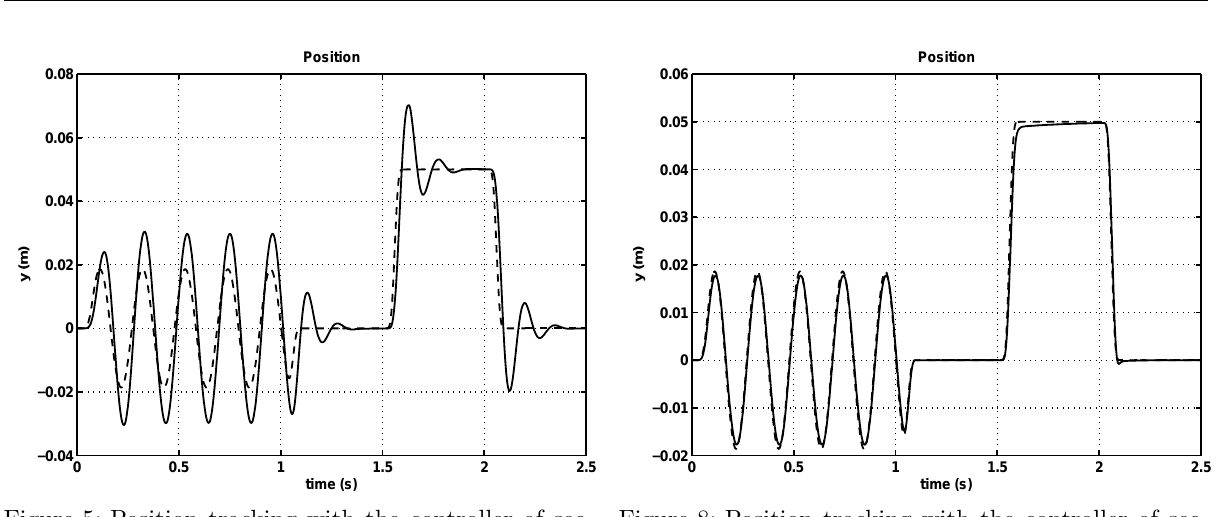
Figure 8: Position tracking with the controller of sec- tion 4.